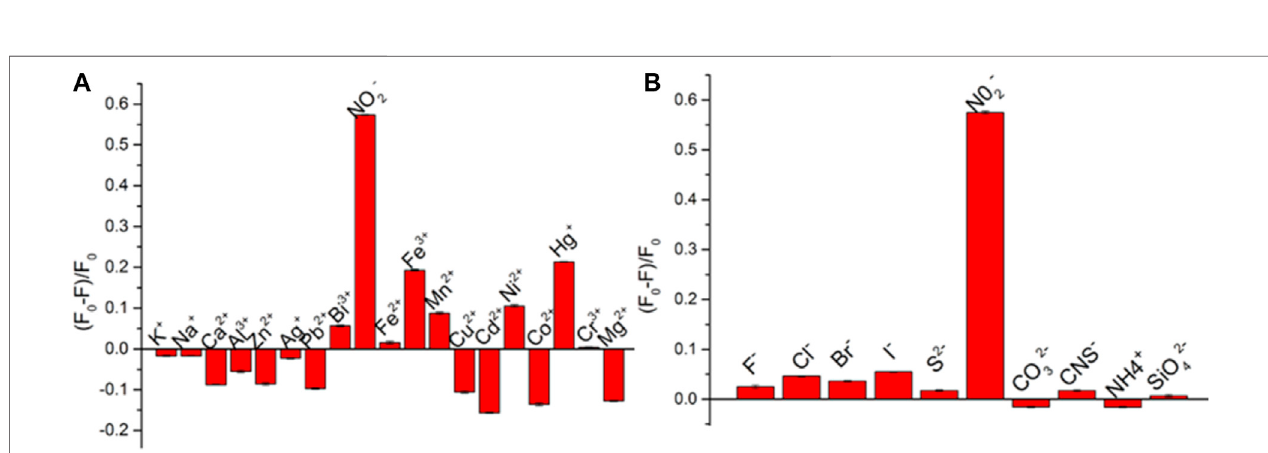
FIGURE 5 | Selectivity of CuNPs toward I − sensing over other common metal ions (A) and anions (B) . The concentration of all metal ions is 100 μ mol/L.